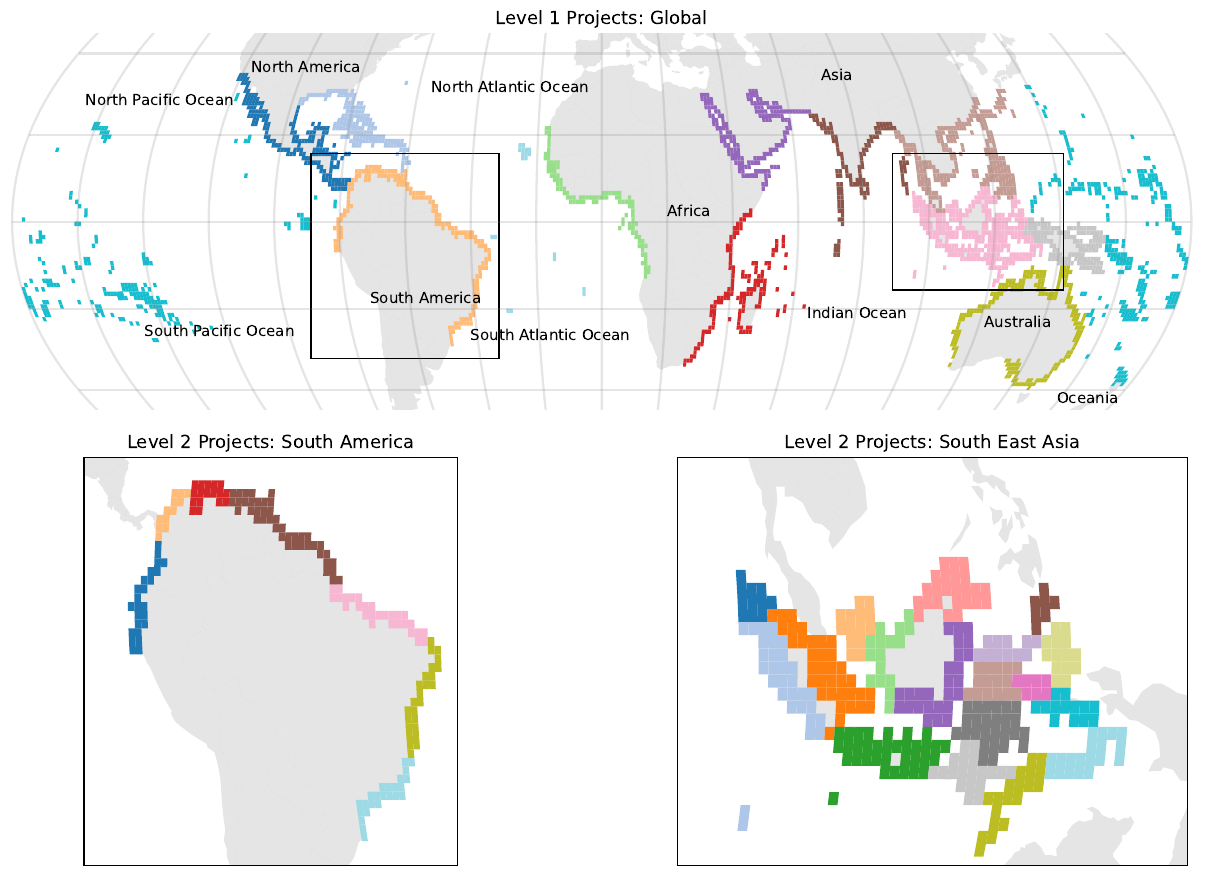
Figure 6. An updated version of GMW geographic projects from [27] used to define the change thresholds. The projects are defined in two levels, the first as broad geography areas (e.g., South America) and then within those regions, the second level of projects are defined. Examples are shown for South America and South East Asia. Colours were randomly assigned to illustrate the different projects at the two levels, where the 1 × 1 tiles have the same colour they are within the same project at that